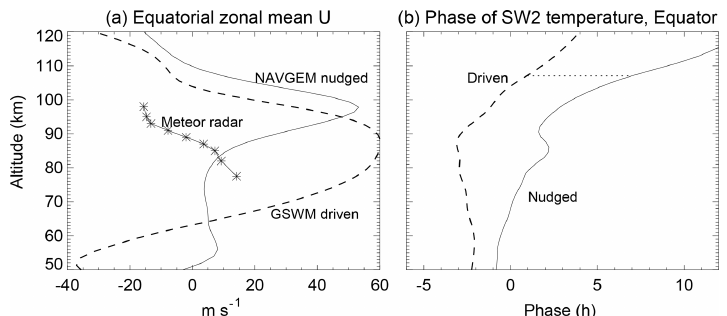
Figure 9. (a) Vertical profiles of monthly averaged, zonally averaged TIME-GCM zonal winds for the GSWM-driven model (dashed line) and the NAVGEM-nudged model (solid line). Also shown for comparison are monthly averaged meteor radar winds for January 2010 taken from Ascension Island (8 ◦ S, 14.4 ◦ W). (b) Associated phase of the SW2 tide for the two TIME-GCM simulations. The thin dotted line is simply a reference fiducial to show the phase difference between the two simulations at 108km.